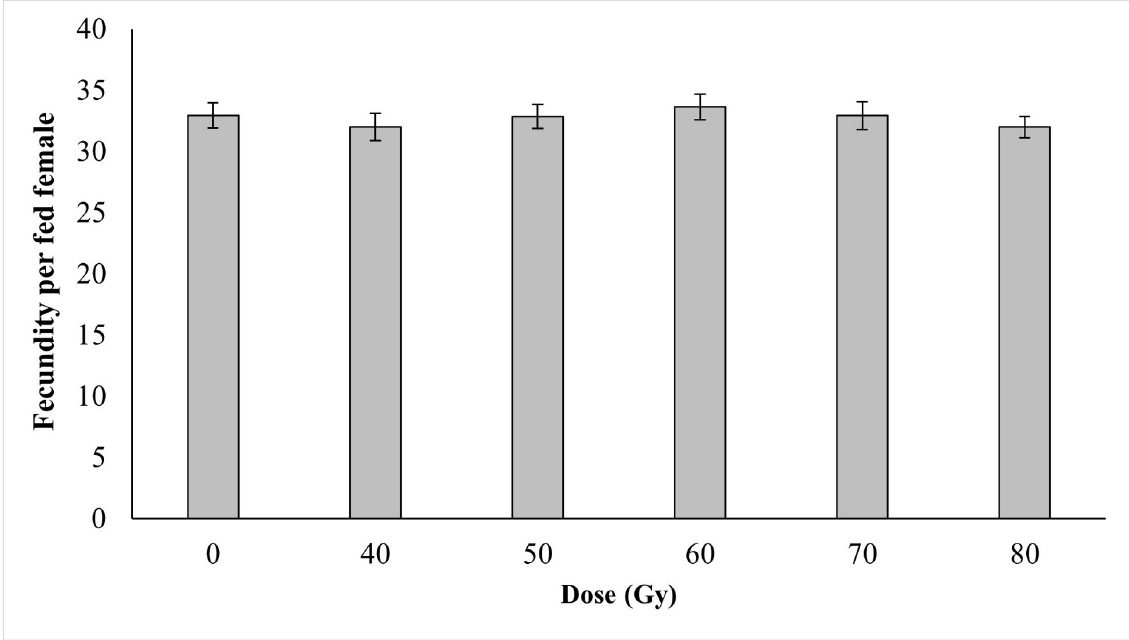
Fig 3. Fecundity per fed female of fertile females matted with irradiated males Ae . aegypti following exposure to different irradiation doses.